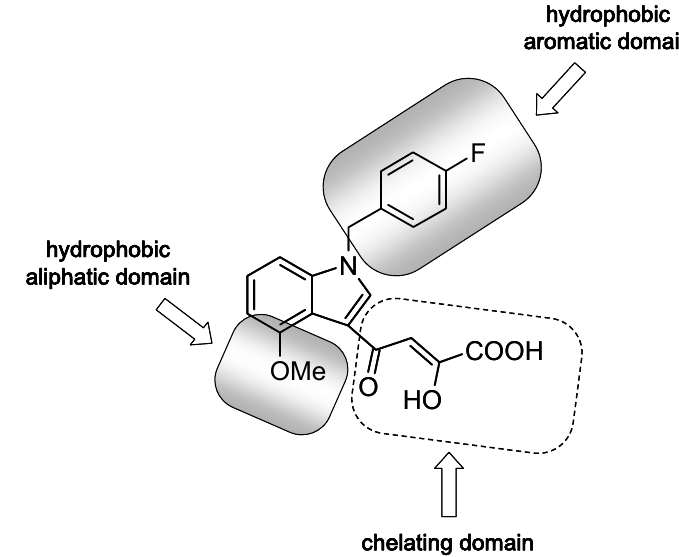
Figure 2. Chemical structure of CHI-1043 ( 3 ); Major structural domains are